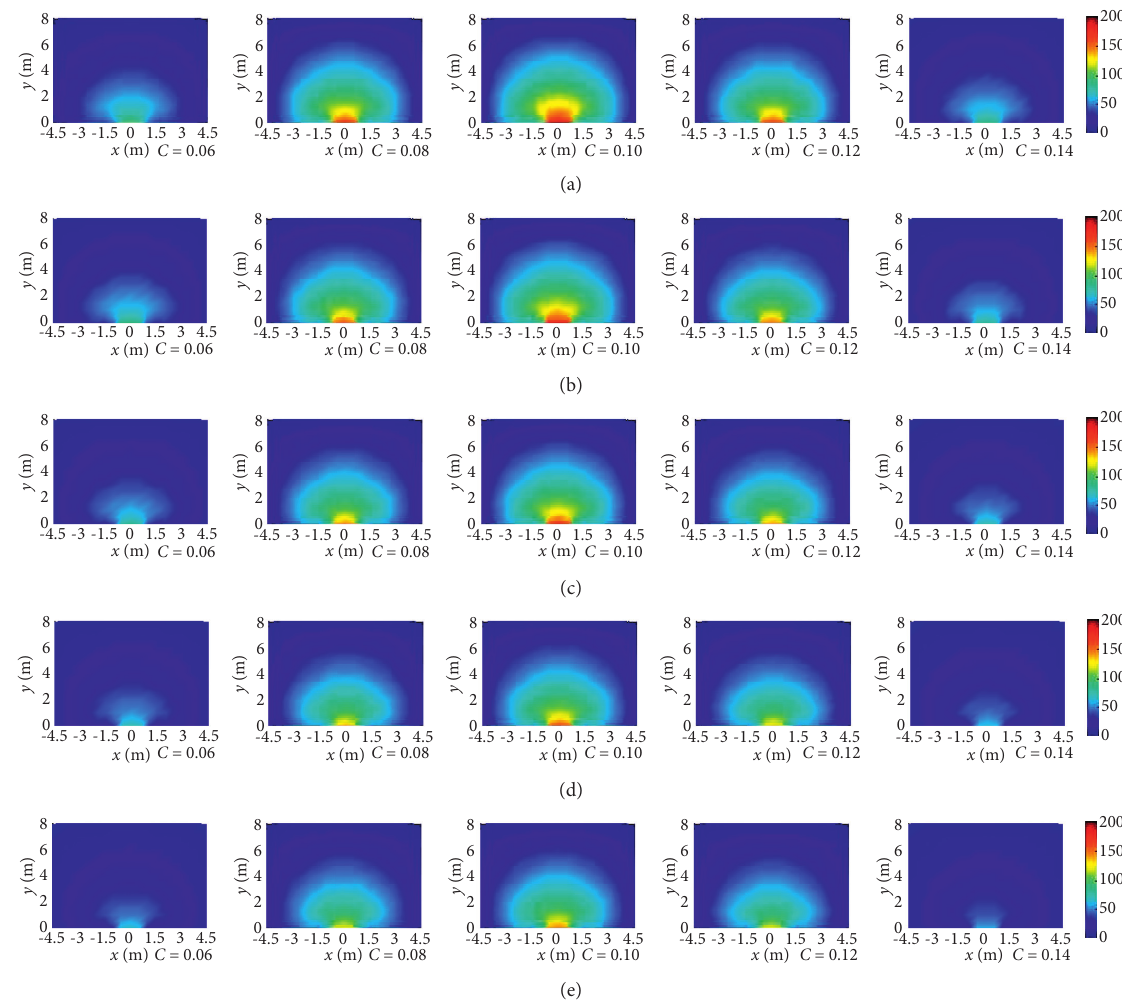
Figure 11: Peak pressure nephograms under different working conditions: Scheme 1 (kPa). (a) (T) � − 60 ° C. (b) (T) � − 30 ° C. (c) (T)